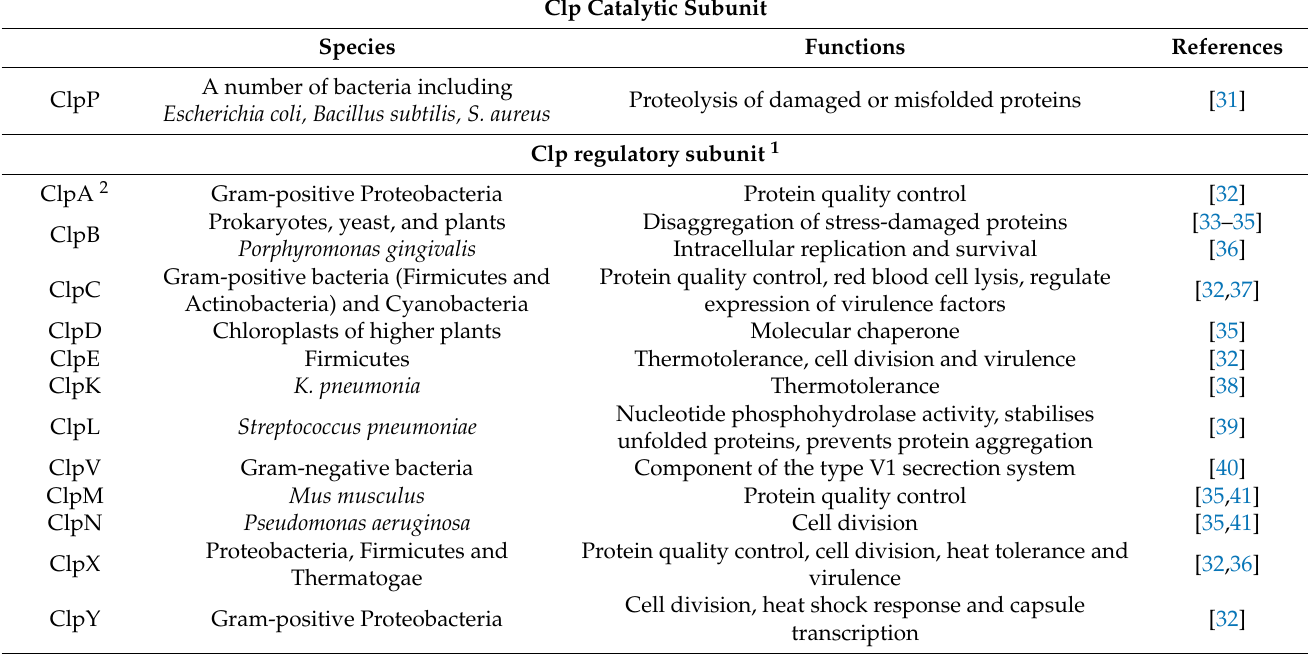
Table 2. Caseinolytic proteins identified across various species, exhibiting diverse